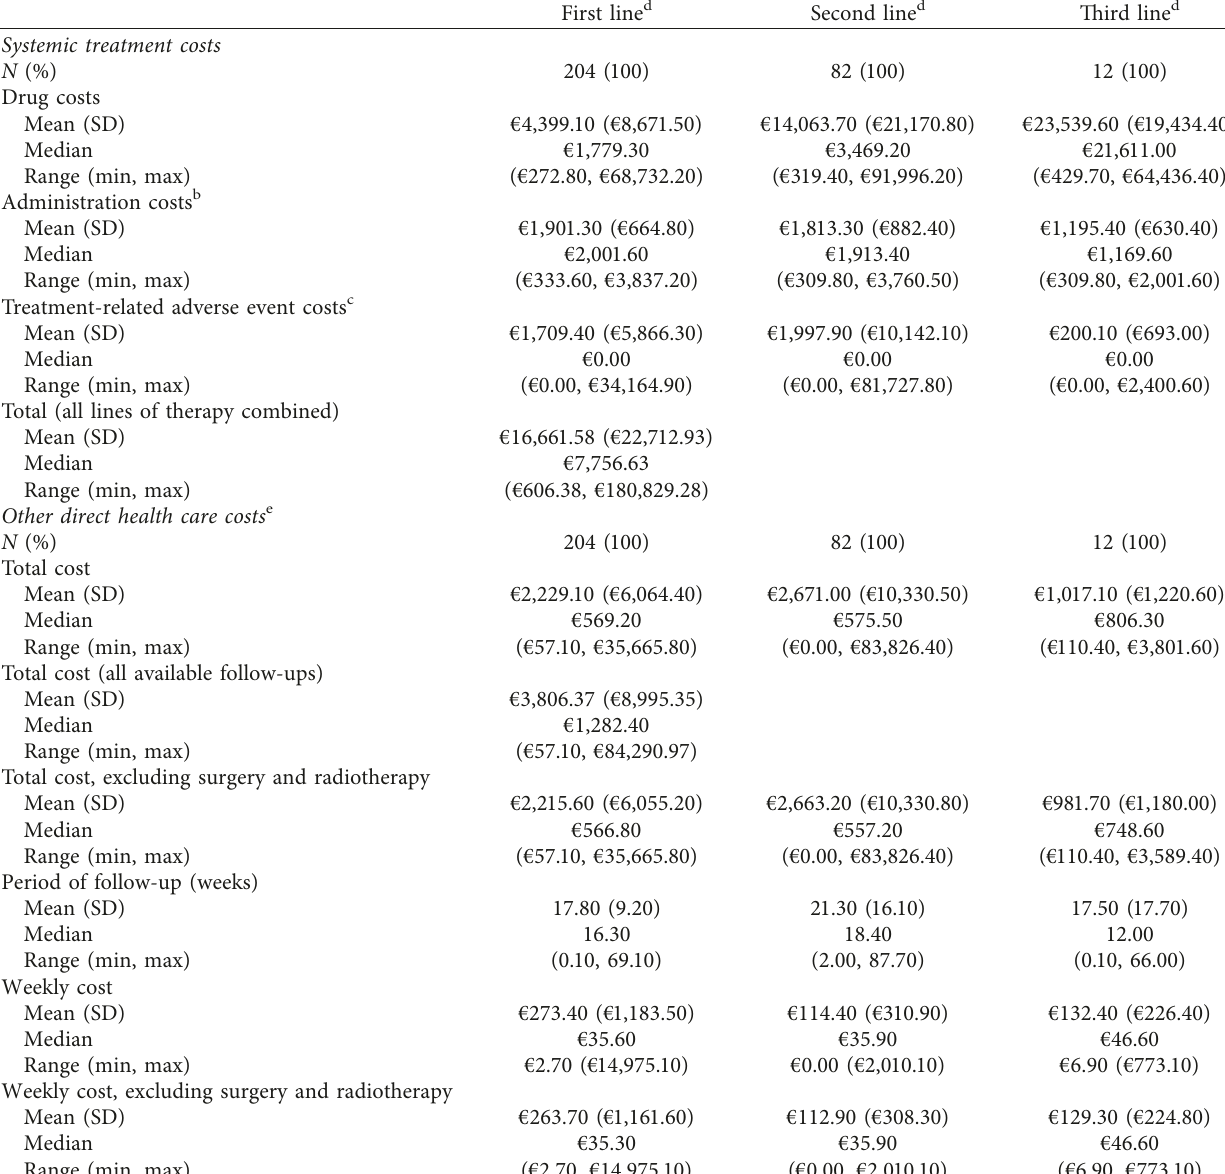
Table 6: Estimated health care costs related to treatment of advanced STS a in Germany ( n �